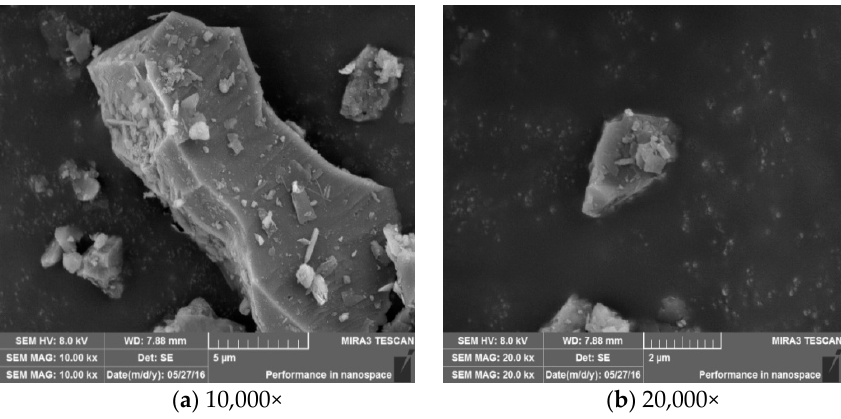
Figure 2. Scanning electron microscope (SEM) images of raw copper-mine tailings’ powder (10,000 ( a ) and 20,000 ( b ) magnification).